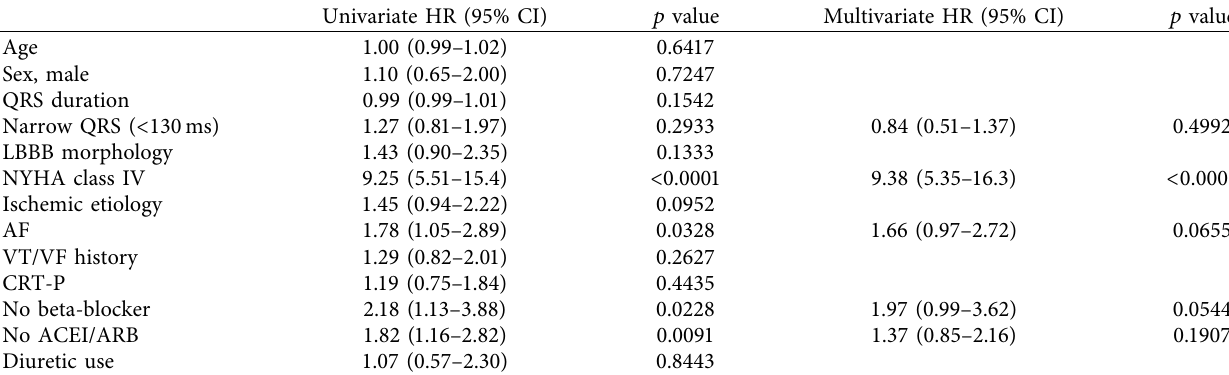
Abbreviations as in Table 1. HR: hazard ratio; CI: confidence